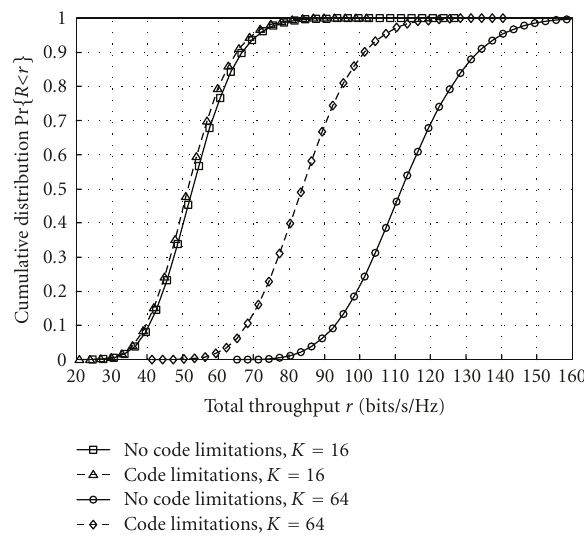
Figure 9: E ff ects of code constraints on total throughput perfor- mance under BCRGA and WFPA.